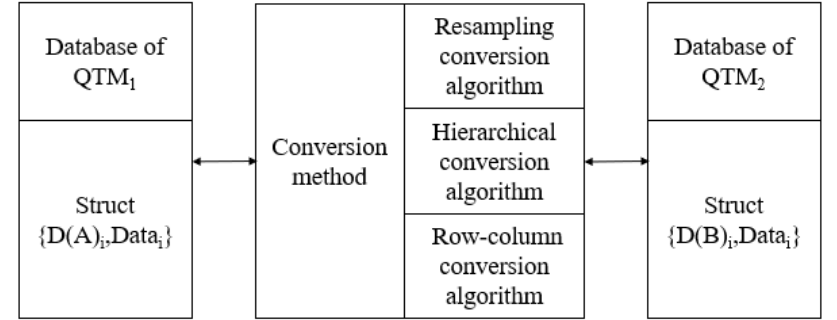
Figure 9. Encoding conversion diagram of QTM 1 and QTM 2 .